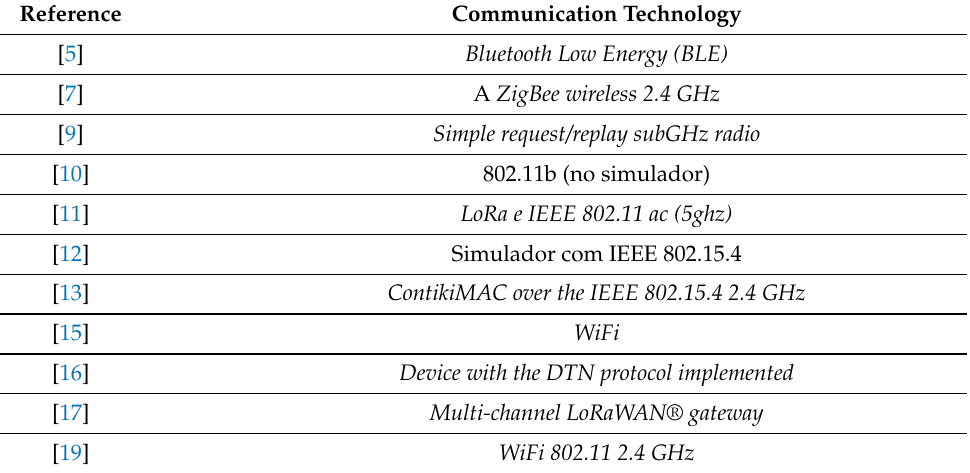
Table 6. Types of